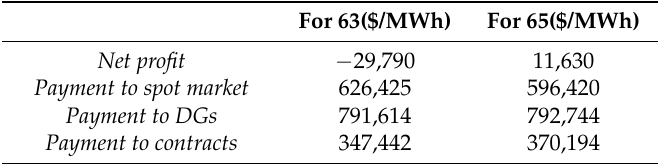
Table 11. Retailer’s profit and costs under different average selling prices in the third scheme.